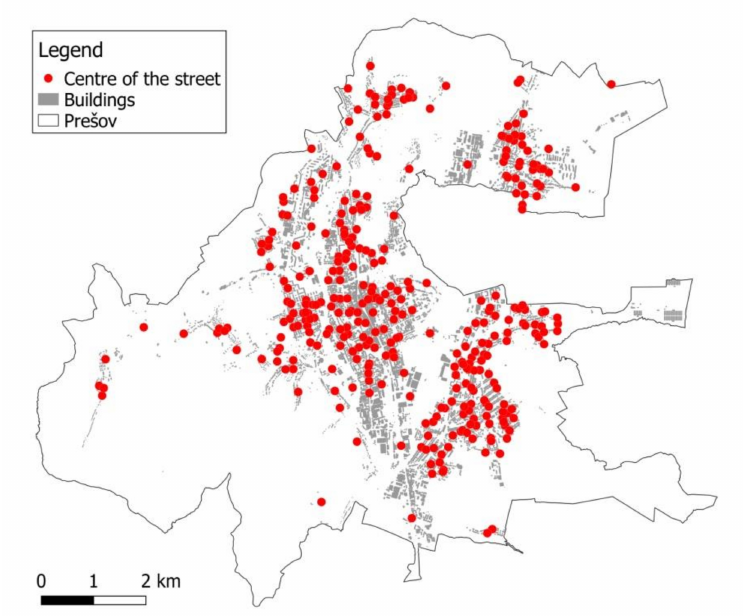
Figure 3. Street centers.